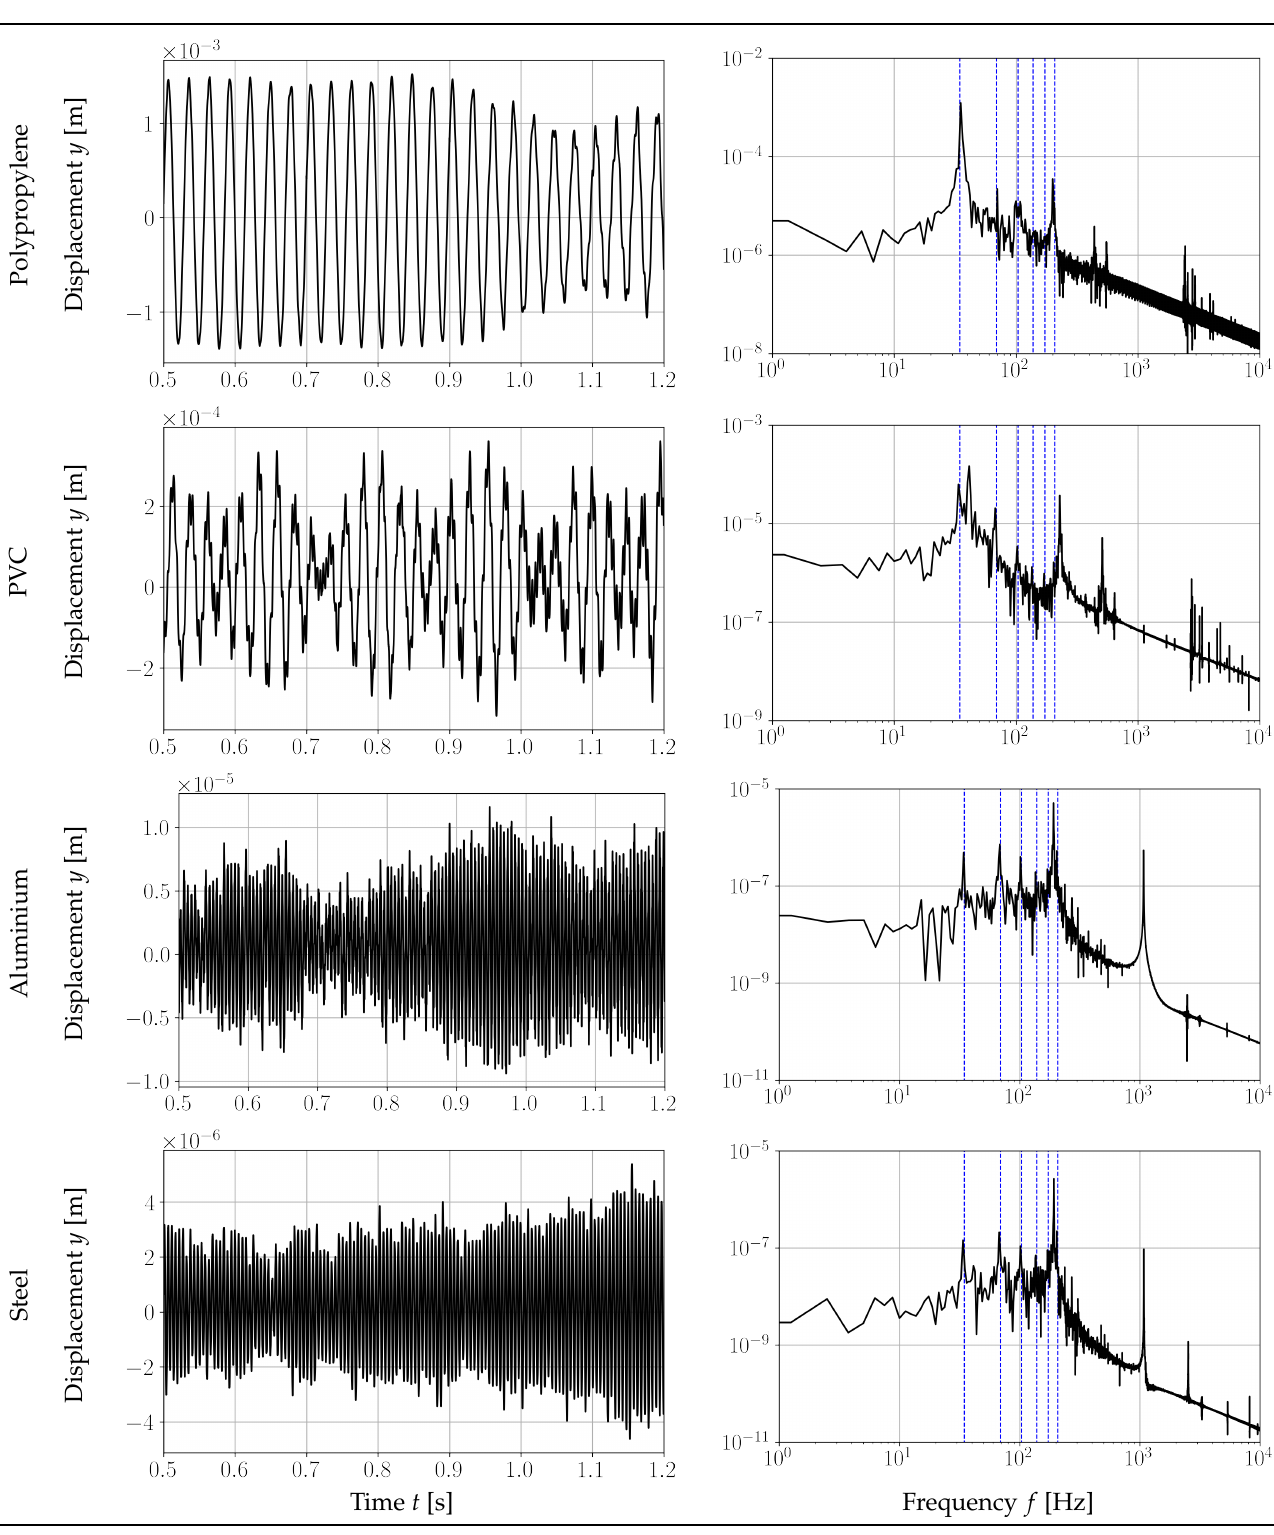
Table 9. Time evolution and frequency spectra of displacement at point S3 for different materials ( Rossiter